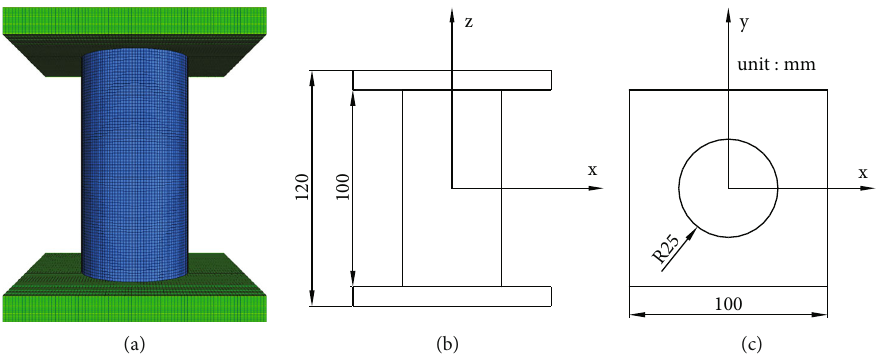
Table 1: Table of mechanical parameters of the model.